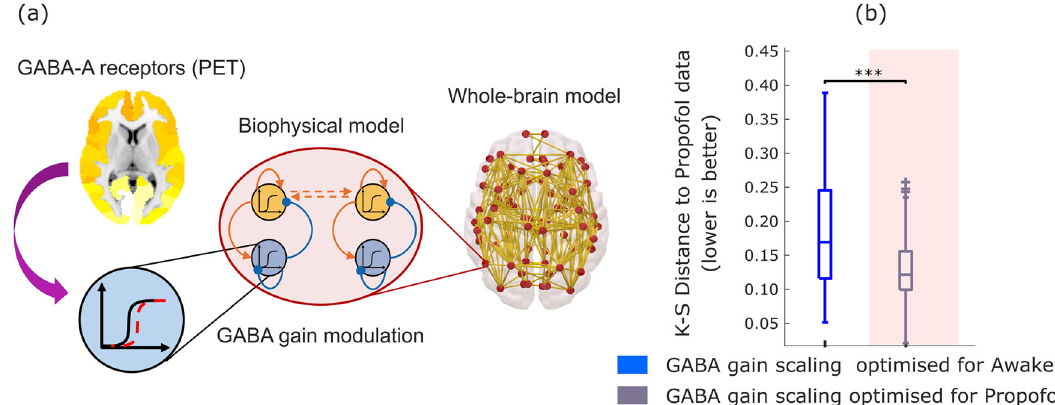
Fig. 2 Modulation of inhibitory gain by empirical GABA-A receptor density improves model fi t to propofol dynamics. a The inhibitory gain of each node in the balanced DMF model is modulated by the regional density of GABA-A receptors, estimated from PET. b Box-plots show the model fi t for n = 100 simulations, quanti fi ed as the KS-distance (lower is better) to the functional connectivity dynamics (FCD) derived from the propofol (anaesthetised) condition, using a value of gain for inhibitory scaling s I derived from calibrating the model with respect to either the awake (blue) or propofol (grey on shaded background) conditions. Middle line: median; box limits, upper and lower quartiles; whiskers, 1.5x inter-quartile range; “ + ” symbol indicates outliers; *** p < 0.001 from t -test. Source data are provided in Supplementary Data 1. We replicated this result using an alternative version of the KS-distance, which in addition to the distribution of FCD values also takes into account the temporal lag between them (Supplementary Fig.